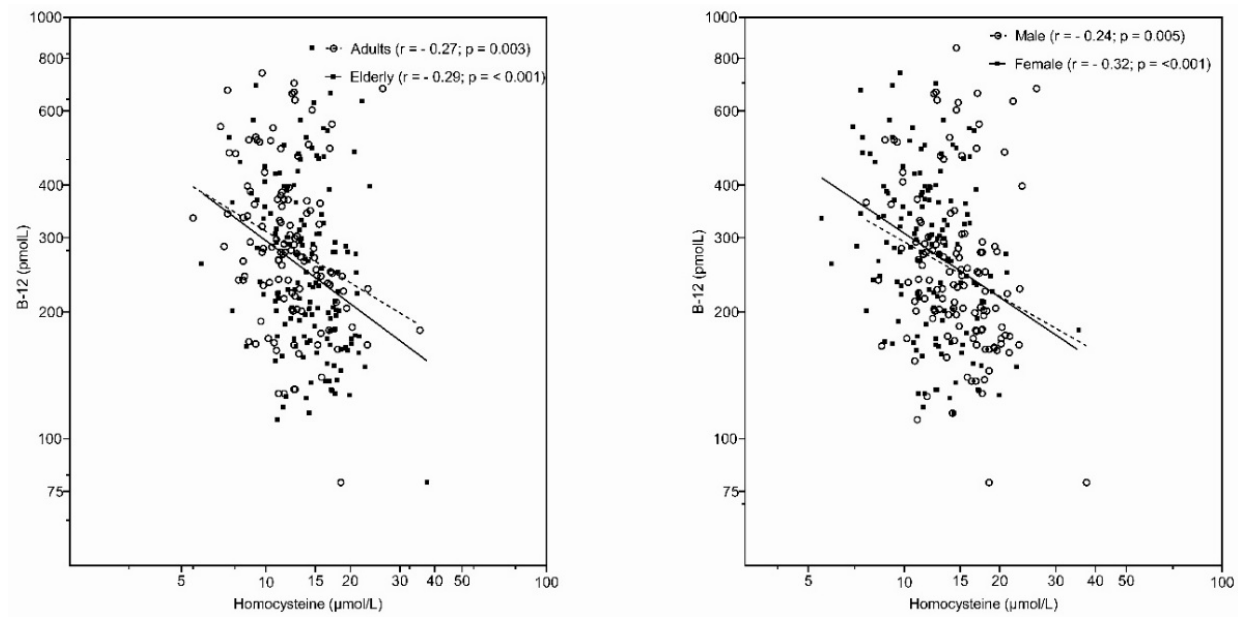
Figure 3. Association of serum vitamin B12 with serum homocysteine concentration in different age cohorts ( left ) and sex groups ( right ) using log scale.